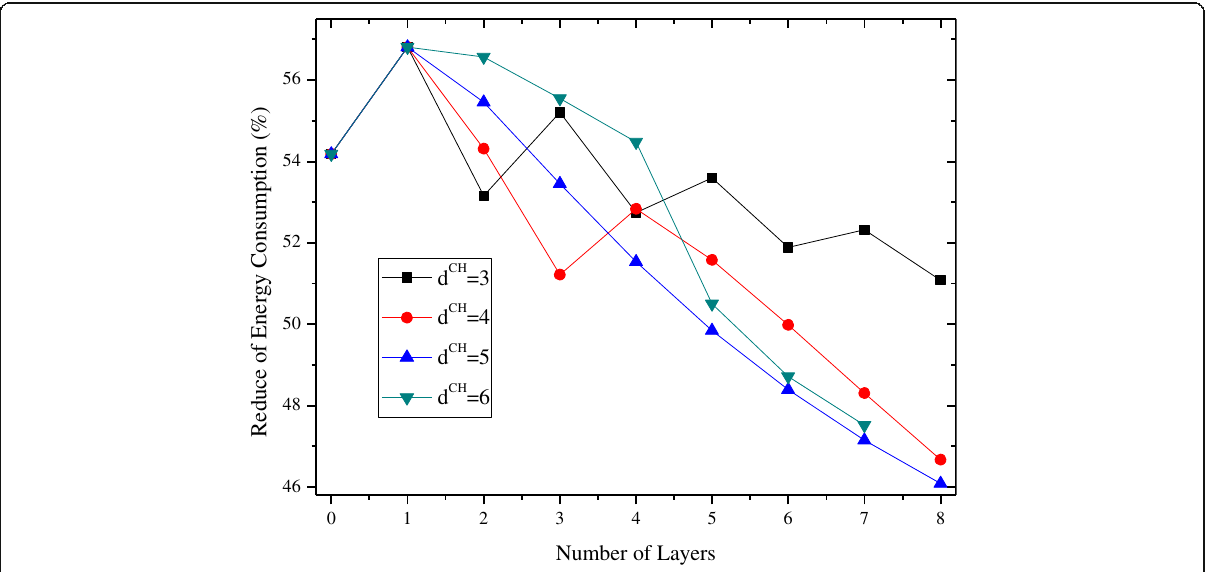
Fig. 18 The reduced percentage of the energy consumption (different d CH